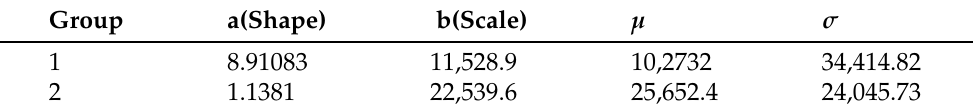
Table 13. Parameter Computation for Category C.